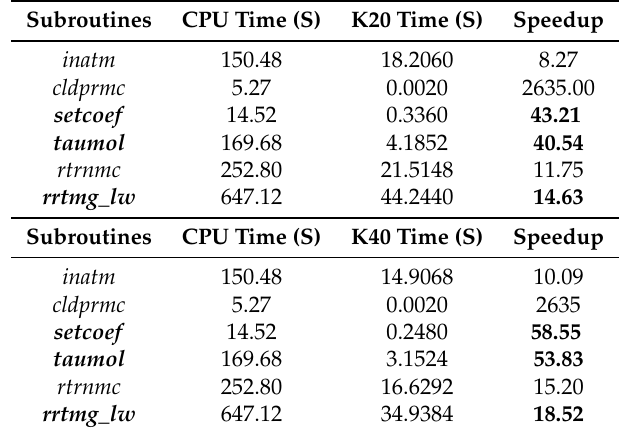
Table 2. Runtime and speedup of the RRTMG_LW 2D acceleration algorithm on one GPU. Here, the block size = 128 and ncol = 2048; inatm , cldprmc , and rtrnmc are with a 1D decomposition; setcoef and taumol are with a 2D decomposition.